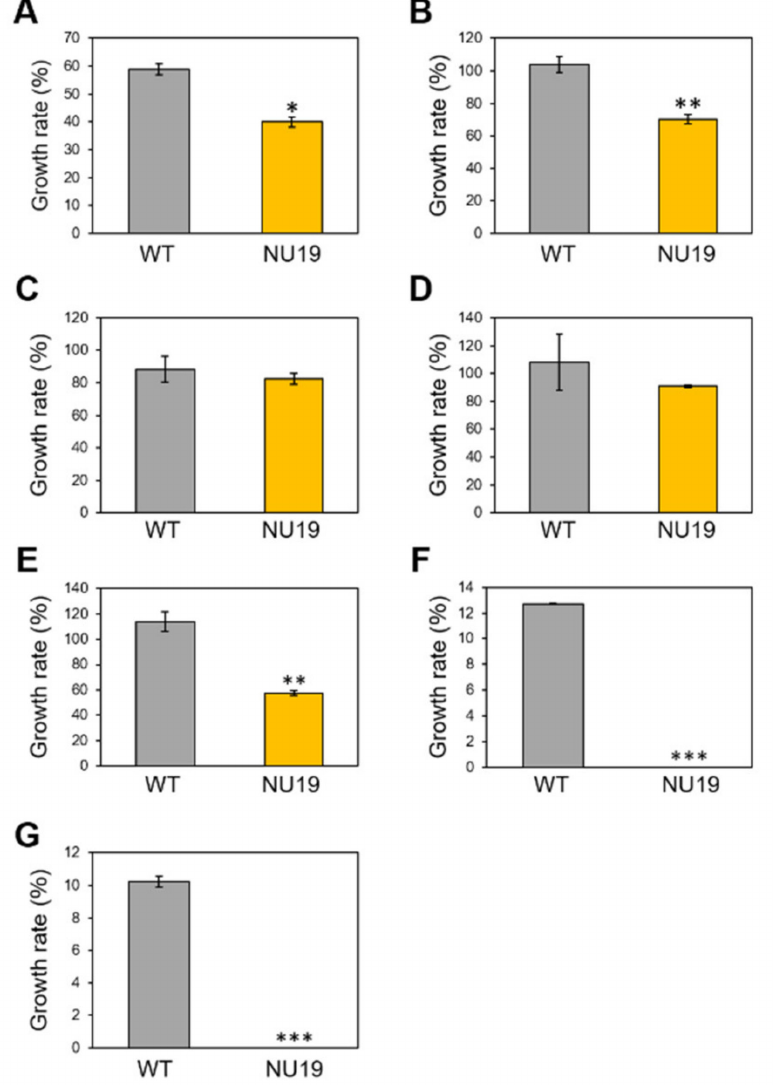
Figure 3. Growth rate of Pseudomonas cannabina pv. alisalensis KB211 WT and NU19 in KB medium with or without plant-derived antimicrobials. The bacterial suspensions were standardized to an OD 600 of 0.01 with KB, and after 6 h incubation, 200 µ M brassinin ( A ), sulforaphane ( B ), camalexin ( C ), daidzein ( D ), genistein ( E ), indole ( F ), and phloretin ( G ) were added to each sample. Bacterial growth was measured at OD 600 after 24 h incubation. Asterisks indicate a significant difference from the Pcal WT in a t -test (* p < 0.05, ** p < 0.01, *** p <